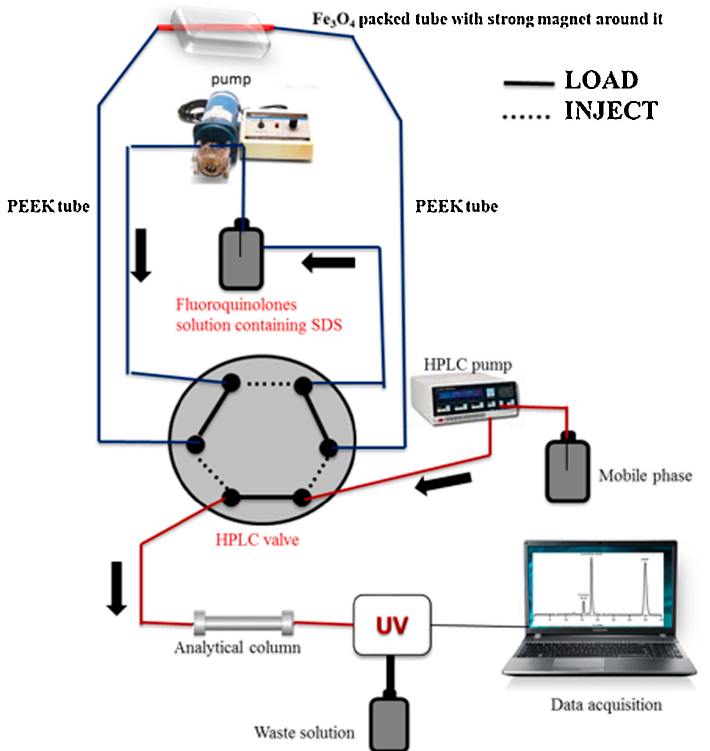
Figure 6. Instrumental setup for the determination of fluoroquinolones. Adopted from [147] with permissions.